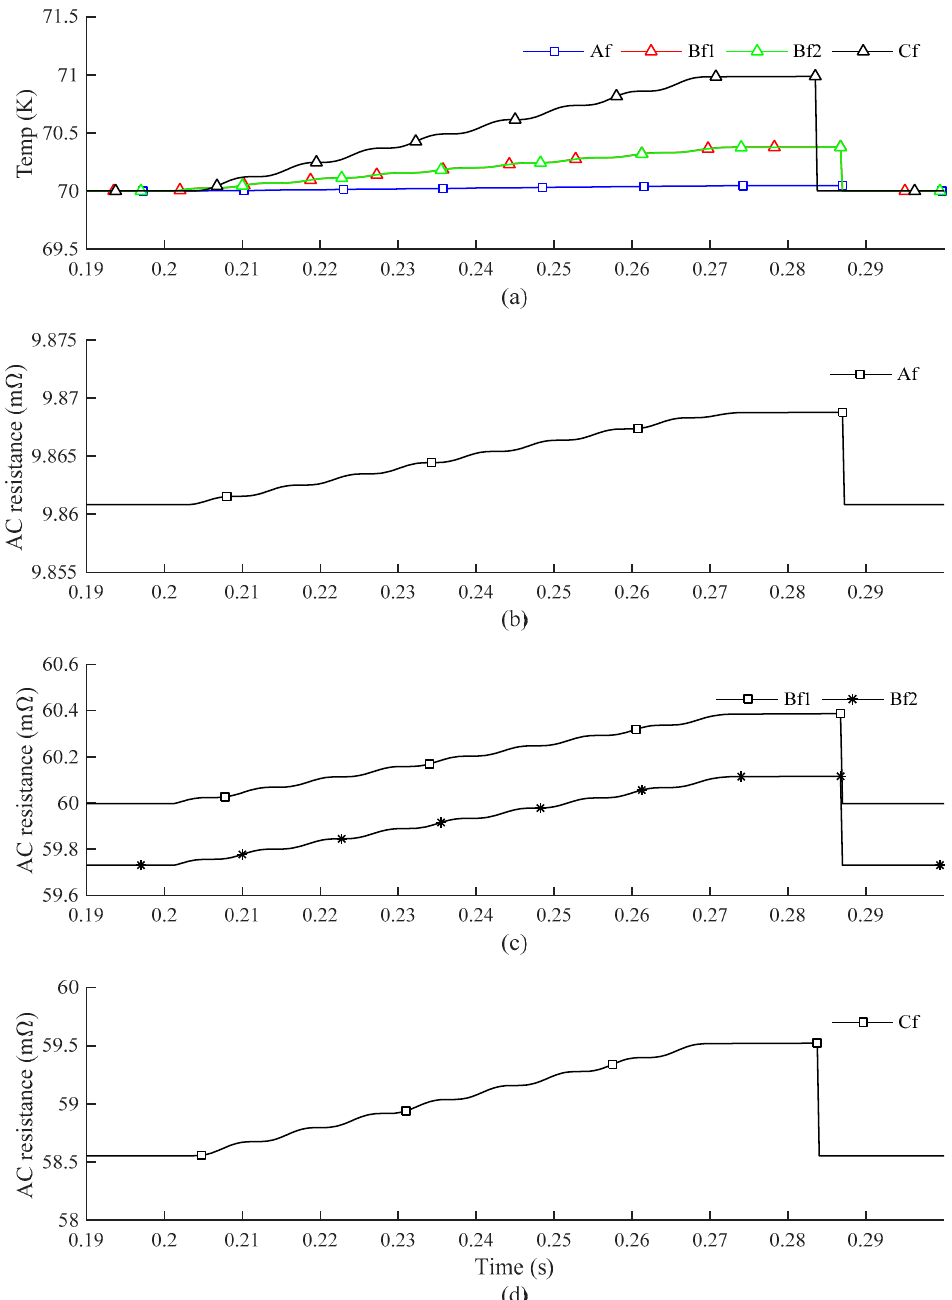
Figure 11. The temperature of the Cu-former layers and the equivalent AC resistances of each phase in the HTS cable: ( a ) temperature of the Cu-former layers; ( b ) resistance of the former Af ; ( c ) resistances of the former Bf 1 and Bf 2 ; and ( d ) resistance of the former Cf .